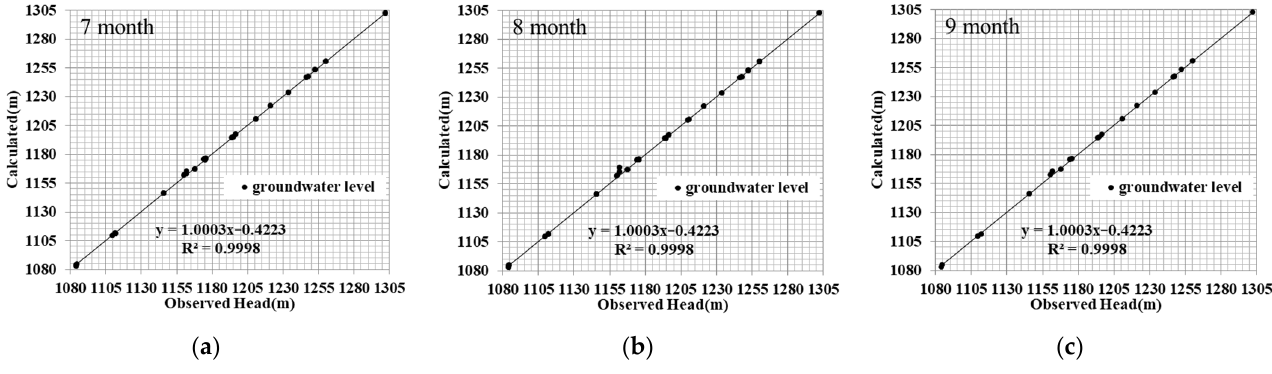
Figure 7. Comparison of observation head and calculated head of 21 monthly continuous monitoring wells. Table 3. Results of groundwater budget in the study area.